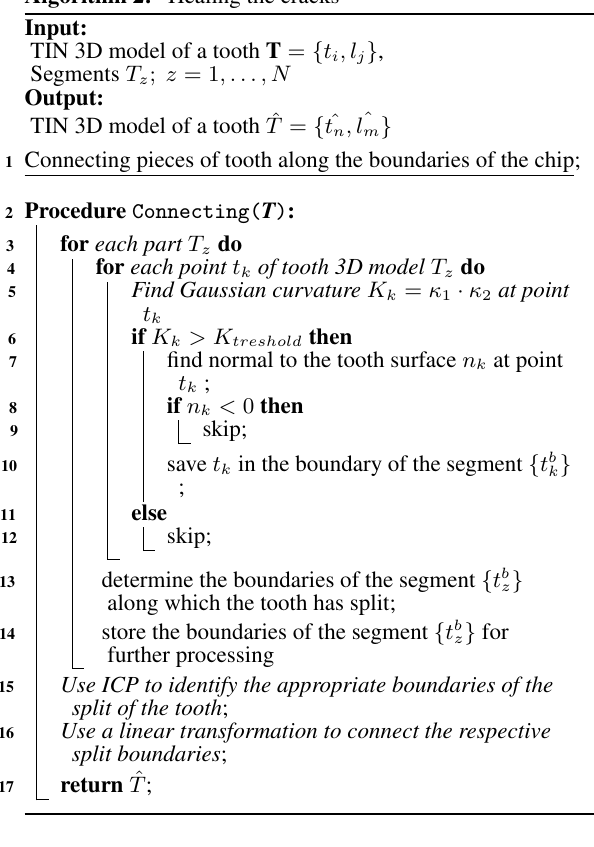
Algorithm 2: ”Healing the cracks”